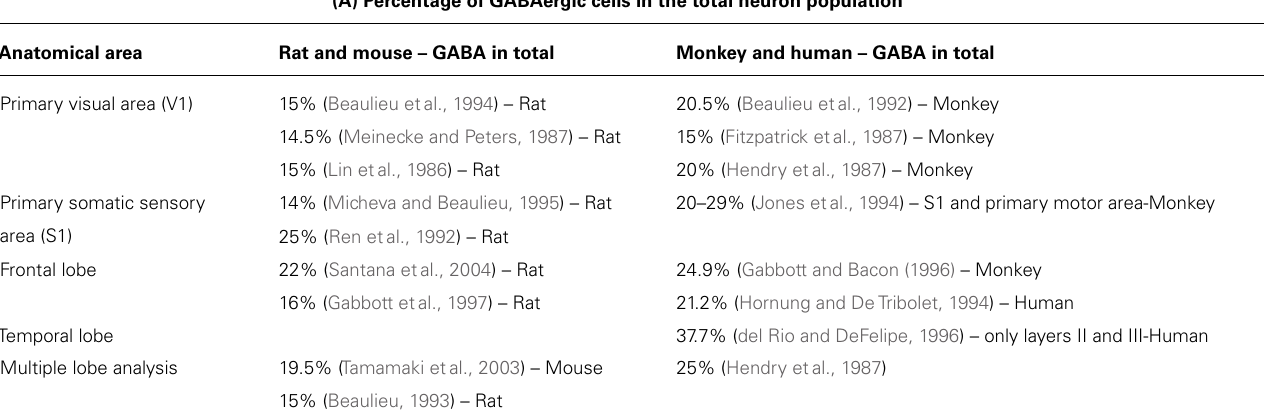
Table 1 | Overview of publications quantifying proportion of GABAergic and calretinin neurons in the neocortex of rodents and primates. (A) Proportion of GABAergic cells in population of all neurons, and (B) proportion of calretinin neurons inside the GABAergic population. (A) Percentage of GABAergic cells in the total neuron